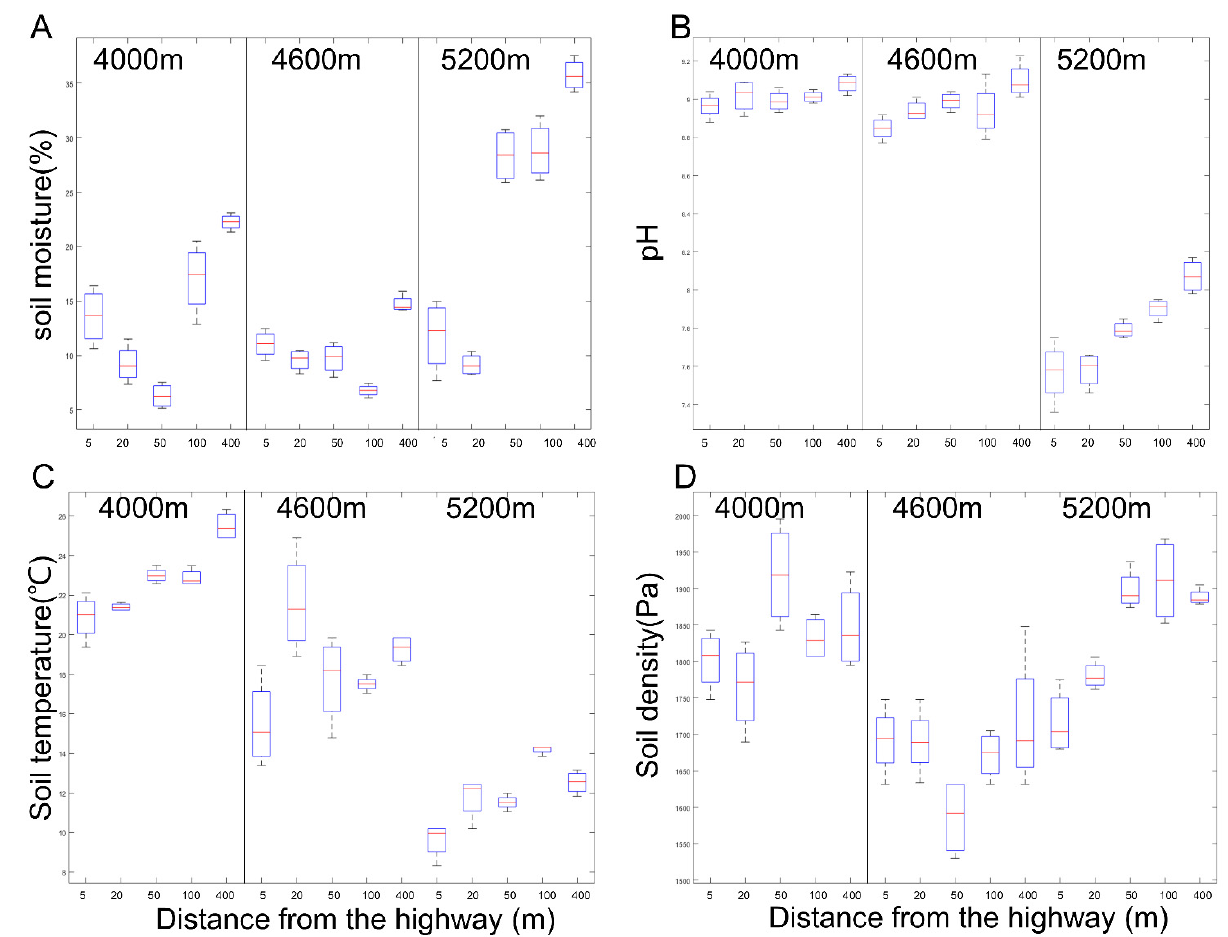
Figure 3. Comparison of soil: ( A ) soil moisture content, ( B ) pH, ( C ) soil temperature and ( D ) soil density between treatments at 5, 20, 50, 100, and 400 m from the curb G109 highways at altitudes of 4000 m (L), 4600 m (M), and 5200 m (H).